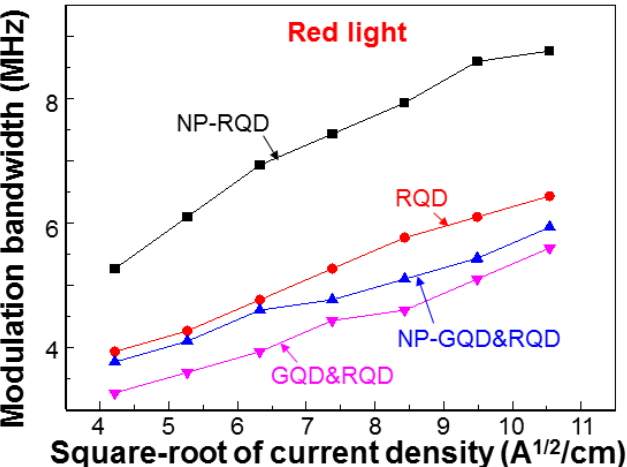
Figure 12. MBs of red light in all the samples with RQD as functions of the square root of injected current density.